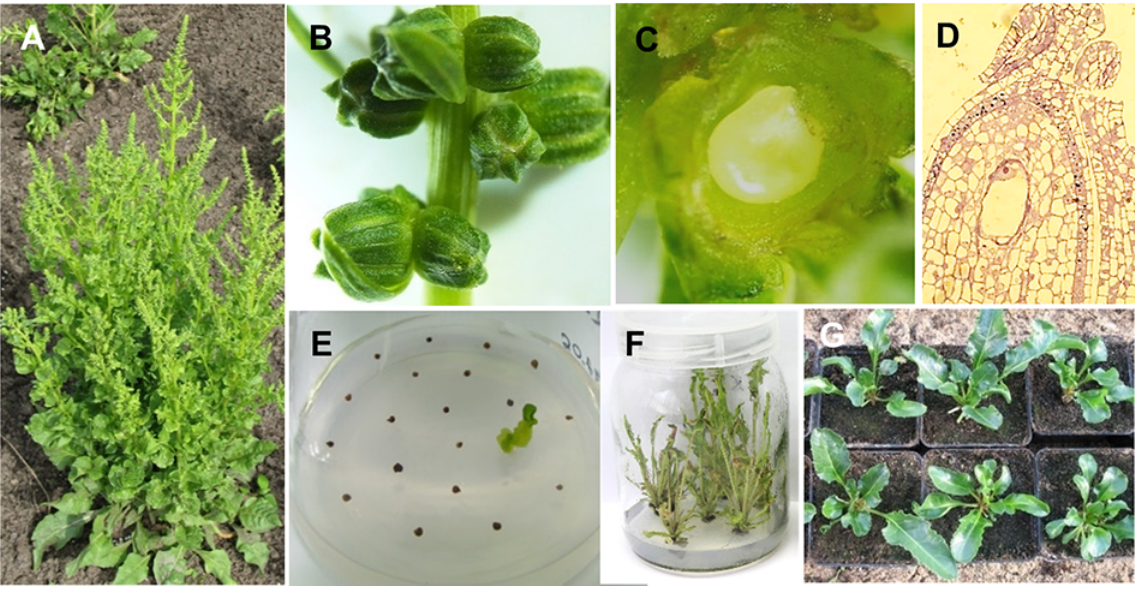
Figure 9 Gynogenesis in unfertilized ovule culture of sugar beet ( Beta vulgaris L.). ( A ) Donor plant during field cultivation. ( B ) Floral buds suitable for ovule isolation. ( C ) e ovule and the ovary. ( D ) Morphology of embryo sac with the unfertilized egg cell before division. ( E ) e ovules on induction medium. ( F ) Haploid plantlets on regeneration medium. ( G ) Doubled haploids, 2 months aer colchicine treatment and acclimatization to ex vitro